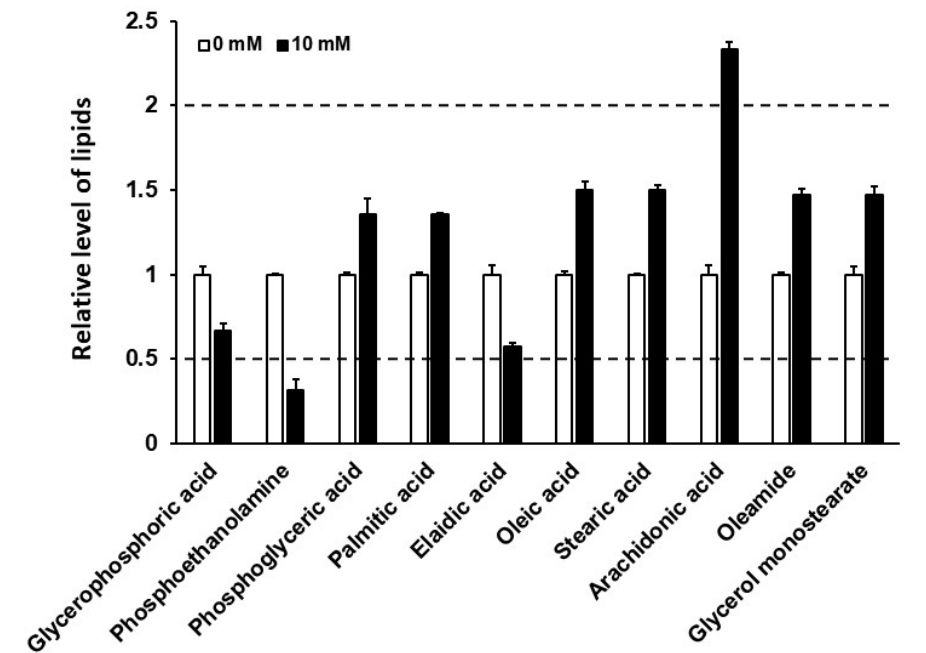
Figure 1. Caffeine intake altered the level of lipid composition in Caenorhabditis elegans . Fold change in fatty acids between the ca ff eine-free diet group (control, white bar) and the ca ff eine-fed group (black bar), as determined by gas chromatography. Fatty acids were extracted from 5000 adult animals for each group. The dotted lines indicate a relative di ff erence of more than 2-fold compared to the control. Significant di ff erences between groups ( p -value) are shown in Supplementary Table S1. Error bars represent standard deviation (SD).